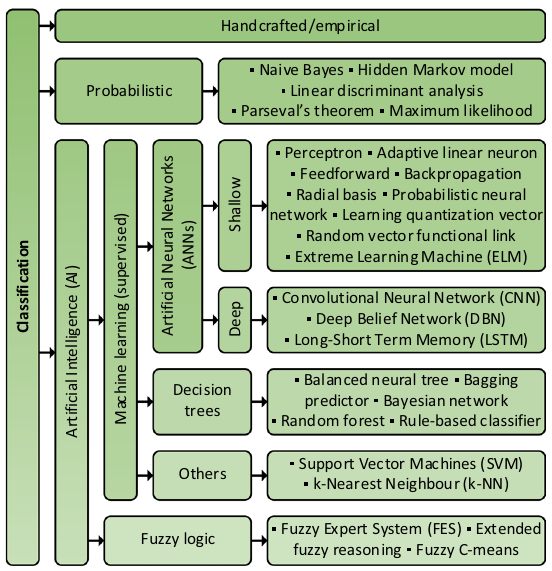
Fig. 11 Taxonomy of methods for classification of